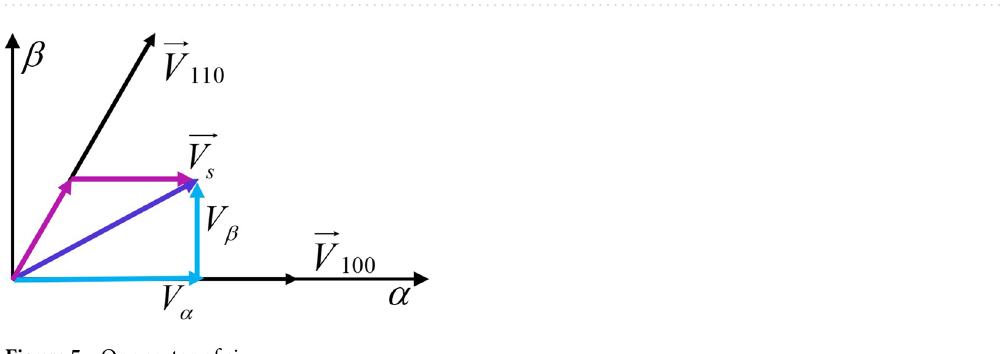
Figure 5. One sector of